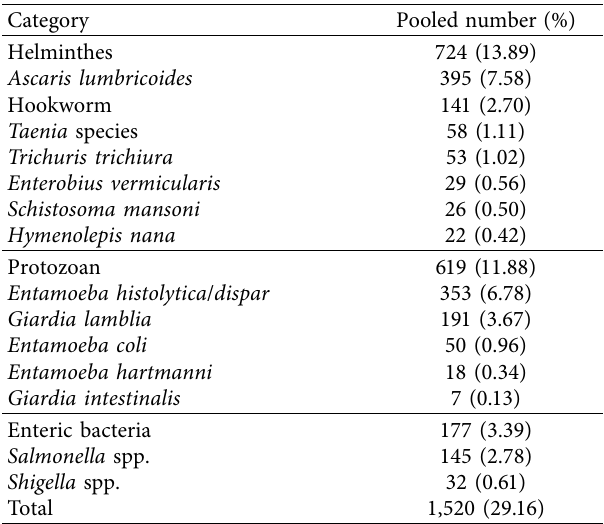
Table 1: Prevalence of intestinal parasites and enteric bacteria among food